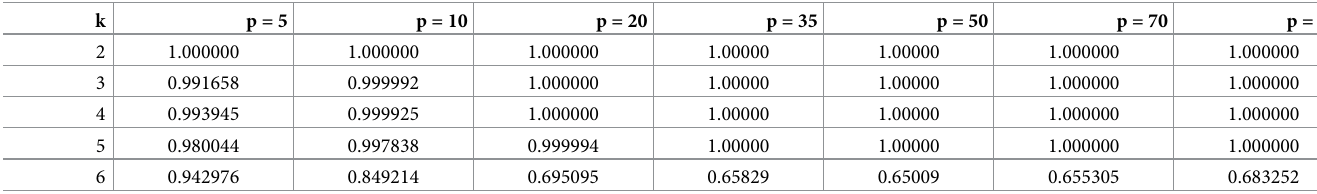
Table 3. Mean accuracy of hard DMM 1 with varied dimensions and number of